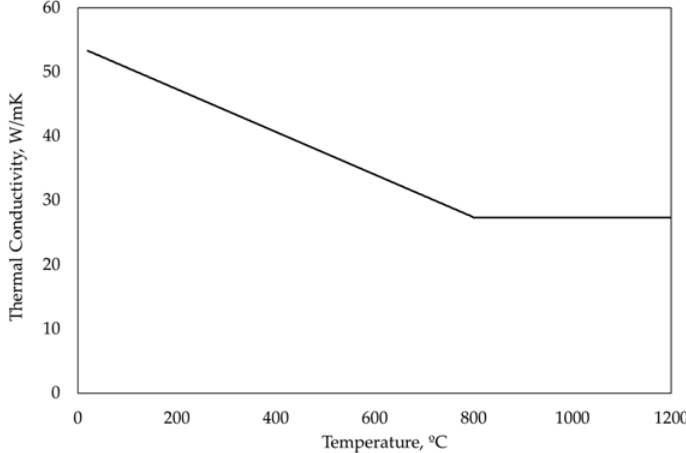
Figure 10. Thermal conductivity of steel.